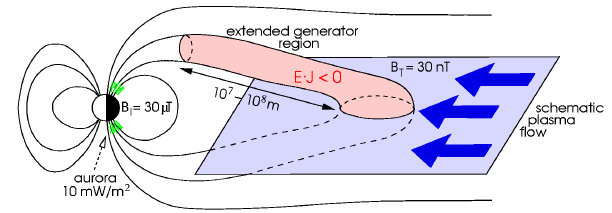
Fig. 1. Order of magnitude estimate for the power density in the generator region. In order to drive a moderately strong energy flux into the ionosphere, of 10mW / m 2 , a power density of ∼ 10 − 13 – 10 − 12 W / m 3 is needed. We assume that the generator extends ∼ 1.5–15 R E along the magnetic field line, and the flux tube cross section at generator level is ∼ 1000 times larger than at ionospheric